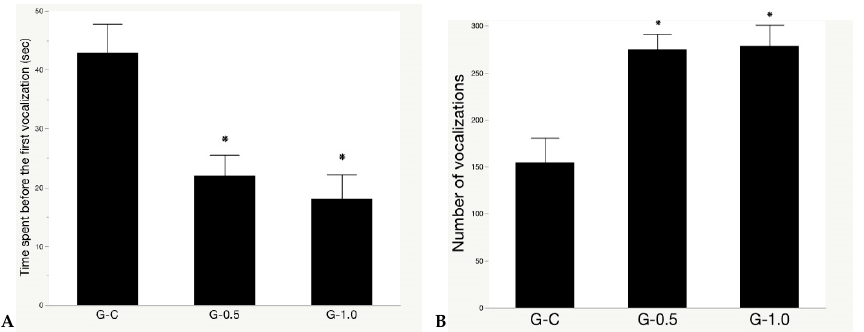
Figure 4. The synbiotic effect on isolation test of broilers exposed to chronic heat stress. ( A ) The latency to give the first vocalization; and ( B ) the number of vocalizations during the test. Treatments: a regular diet supplemented with 0 (G-C), 0.5 (G-0.5), and 1 (G-1.0) g kg − 1 synbiotic, respectively. * significant difference ( p < 0.05) from controls. Data presented as means ± SE (n = 8, 16 birds/treatment).